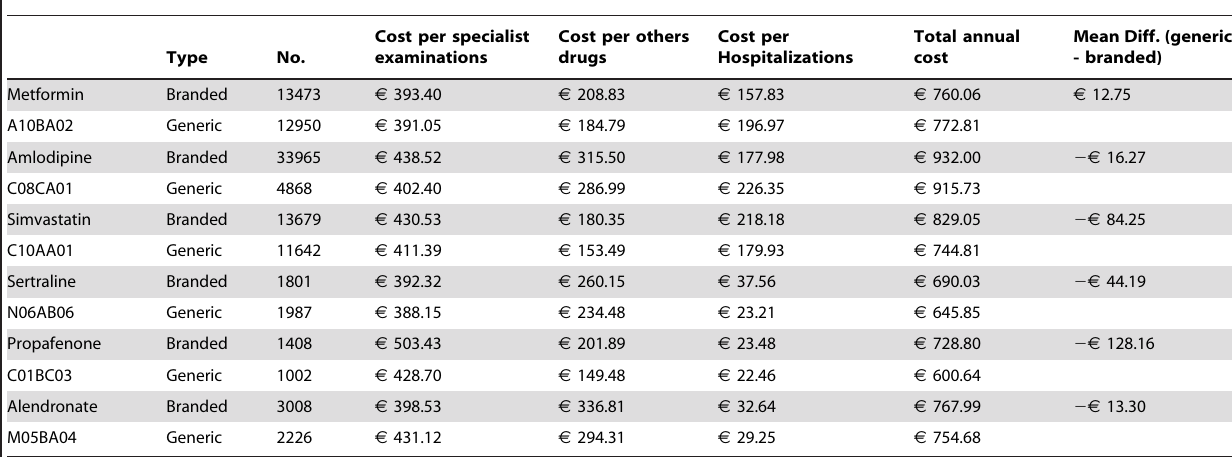
Table 7. Mean yearly health costs per patient among persistent